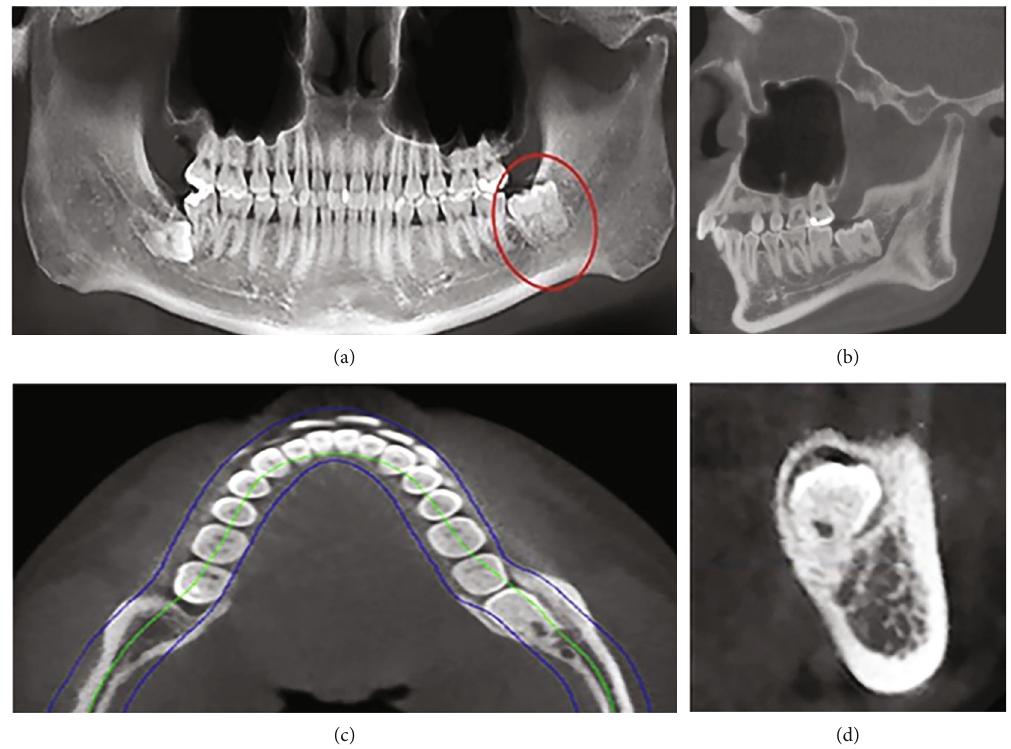
Figure 1: Preoperative CBCT examination. (a) A fourth molar in the mandible left third molar distal; (b – d) the relationship between roots and mandibular canal in coronal, transversal, and sagittal planes. Table 1: Construction of a scoring system for predicting preoperative risk of inferior alveolar nerve injury (IANI).